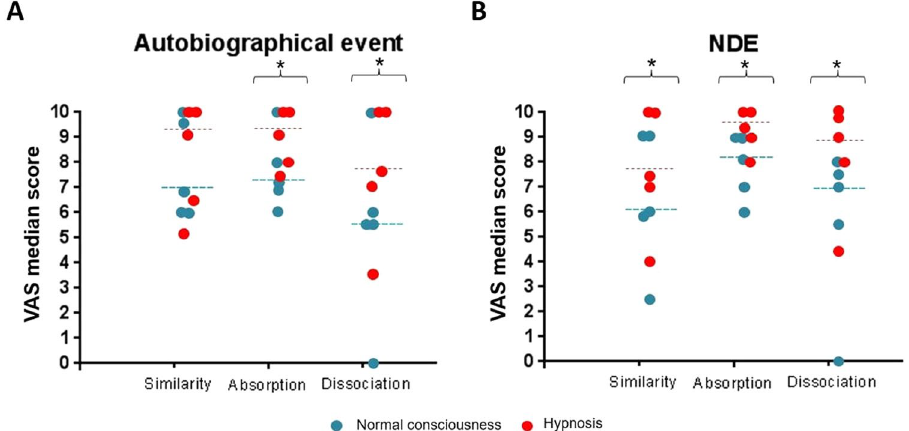
Figure 1. Participants’ Visual Analogic Scales (VAS) scores (and median, dashed lines) relating to level of similarity, absorption, and dissociation in normal consciousness (blue) and hypnotic state (red) for the autobiographical event (AUTOBIO) condition ( A ) and for the near-death experience (NDE) condition ( B ). * p <